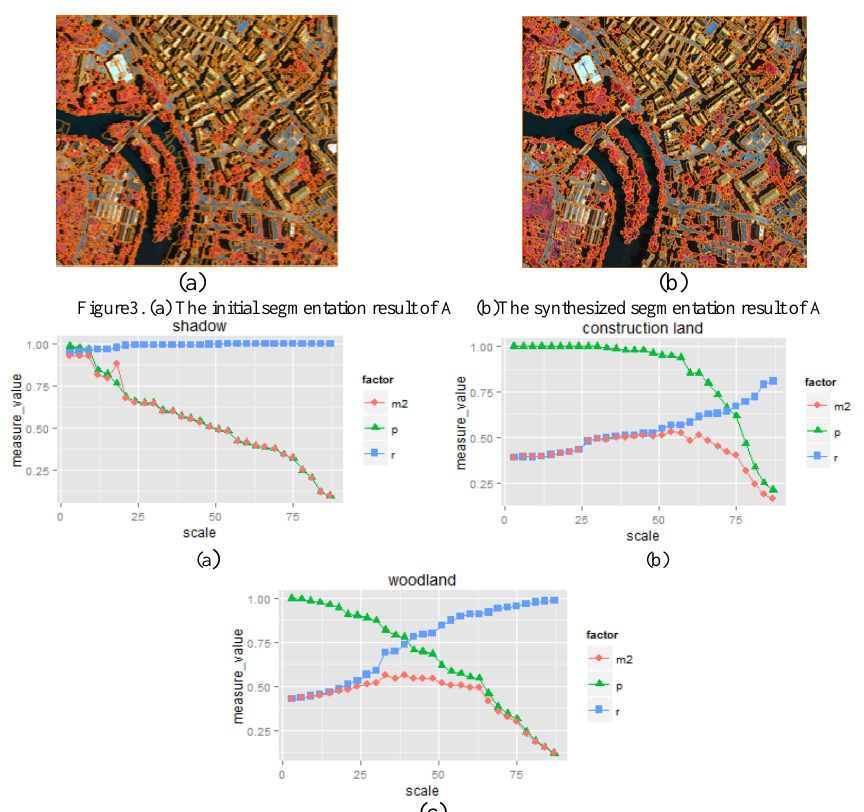
Figure4. Segmentation accuracy evaluation chart of shadow(a), construction land(b) and